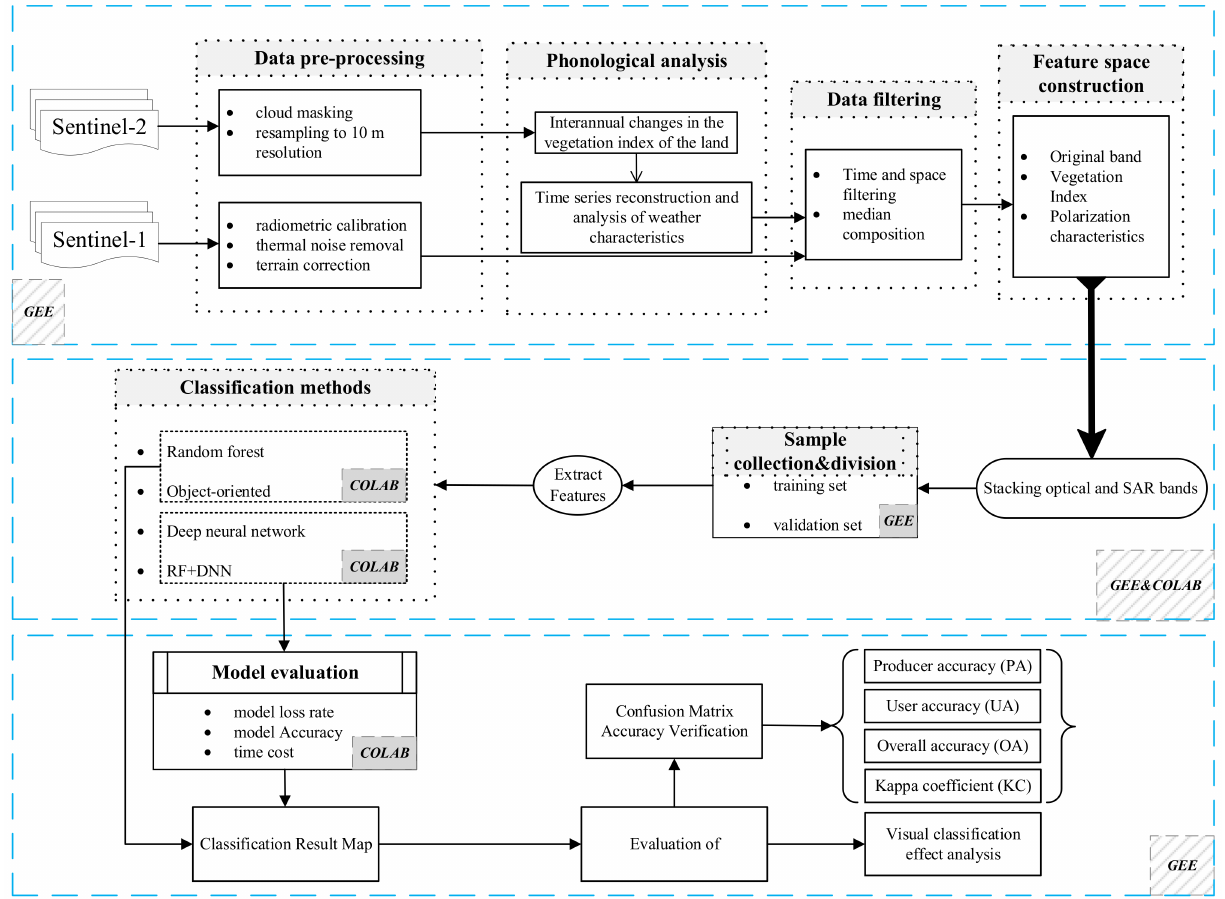
Figure 3. Technical route map. The GEE represents the Google Earth Engine platform and the Colab represents the Google Colaboratory platform in the